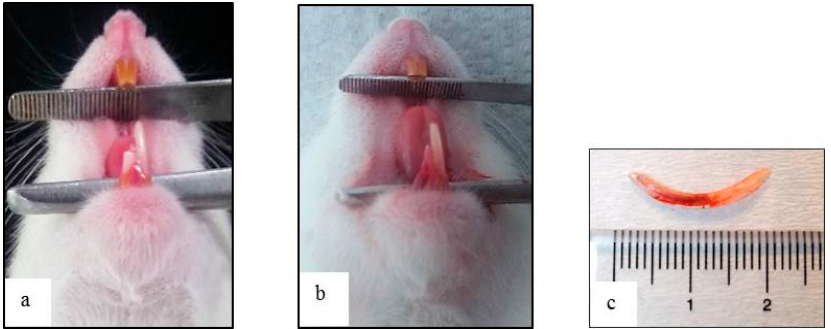
Figure 1. ( a ) Intraoral view after the crown of the mandibular right incisor was cut at the gingival level at 3, 6, and 9 days prior to extraction; ( b ) extraction of the lower right incisor; and ( c ) extracted incisor displaying no signs of